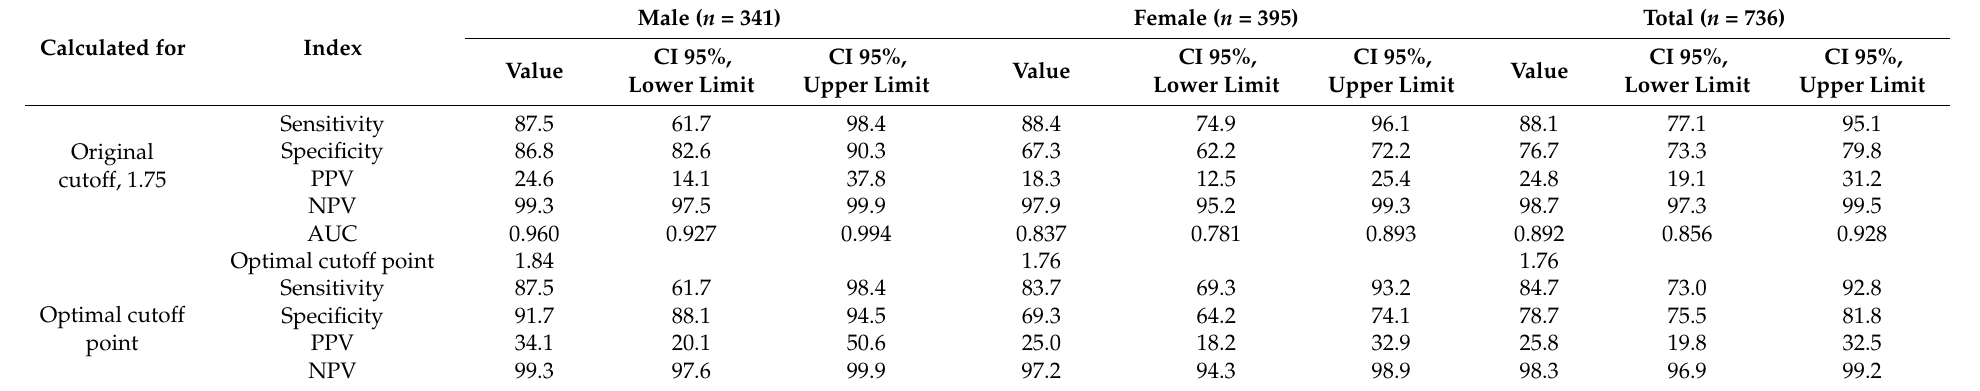
Table 5. Optimum cutoff points, global and gender-specific sensitivity, specificity, positive and negative predictive values in the HSCL-25 scale.